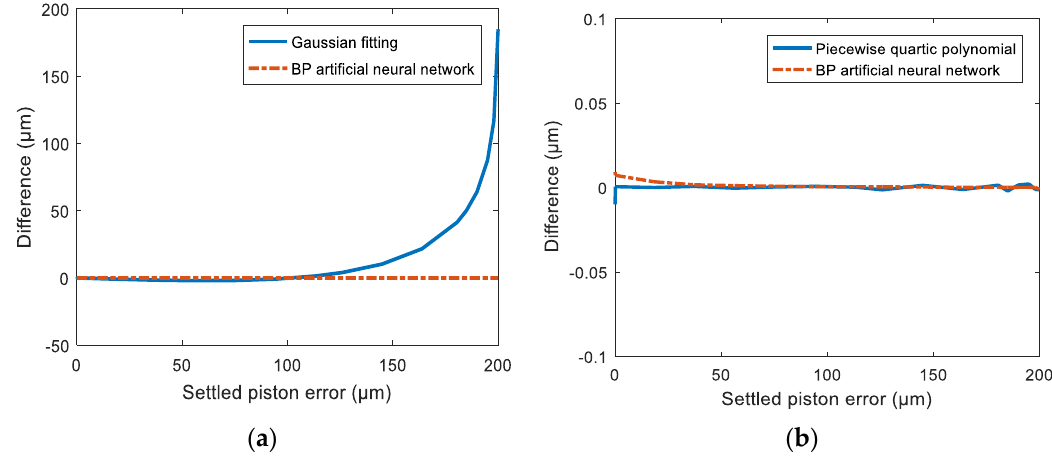
Figure 8. The comparison results on detection accuracy of a BP artificial neural network approach with ( a ) the Gaussian fitting method ( b ) and the two-piece quartic polynomial function fitting method.